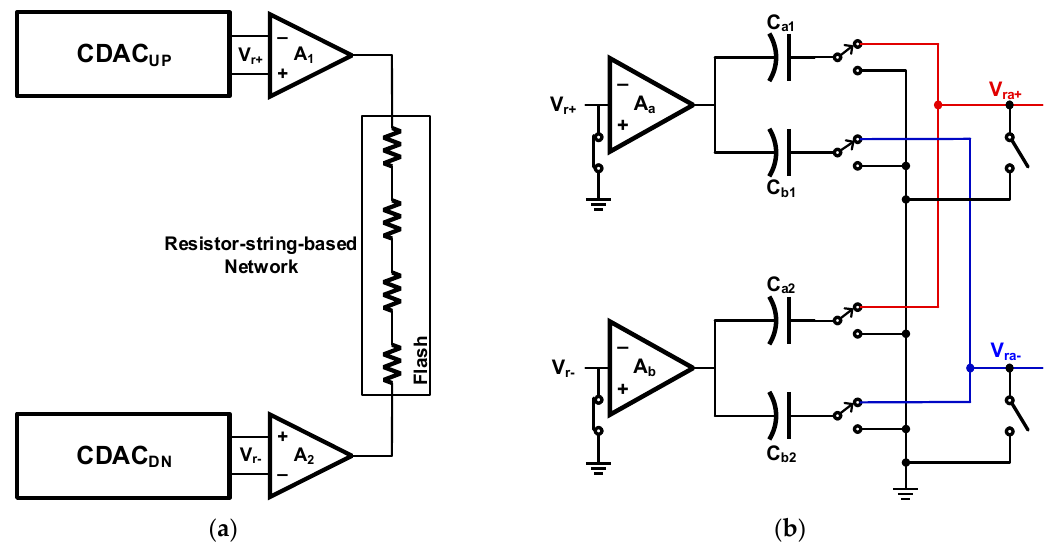
Figure 3. Interpolation schemes: ( a ) Resistor-based interpolation in [19,23]; ( b ) Capacitor-based interpolation in